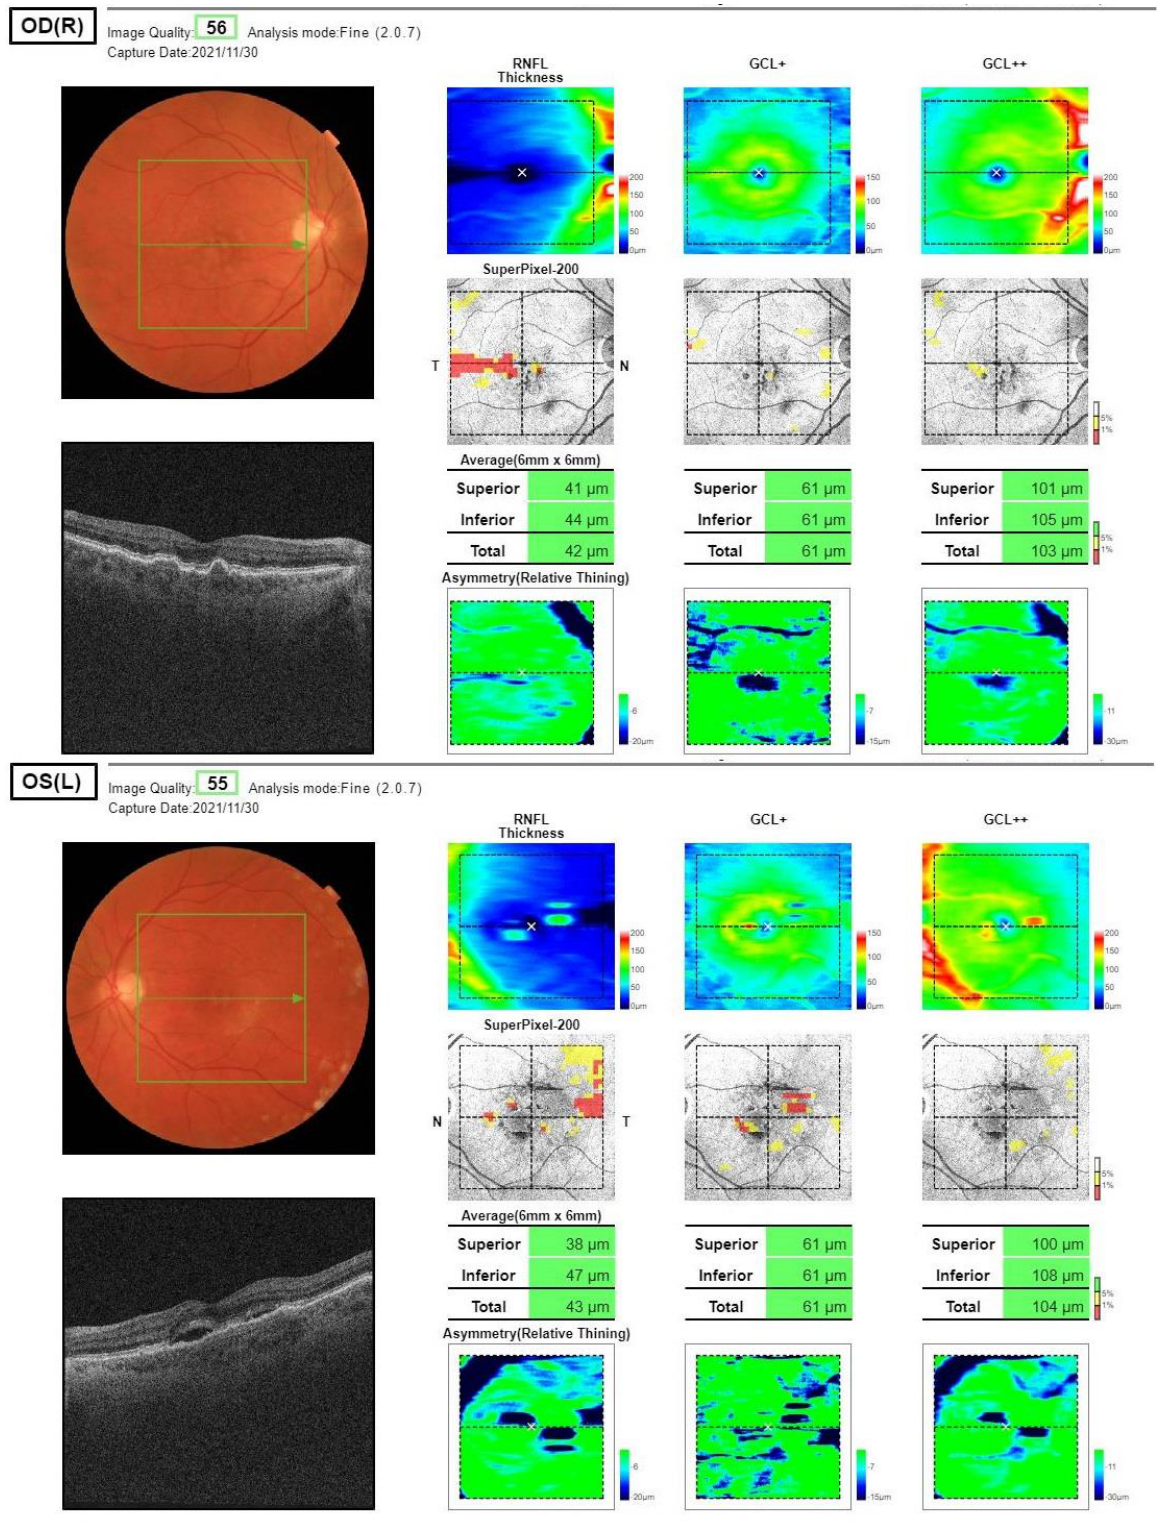
Figure 5. Optical coherence tomography, macula 3D scans (7.0 × 7.0 mm; 512 × 256), both eyes of the same patient. Analyzed values: RNFL total (covers the software-defined area from the inner limiting membrane (ILM) to the border between RNFL and GCL) and GCL+ total (covers the area from the border between RNFL and GCL to the border between the inner plexiform layer (IPL) and the inner nuclear layer